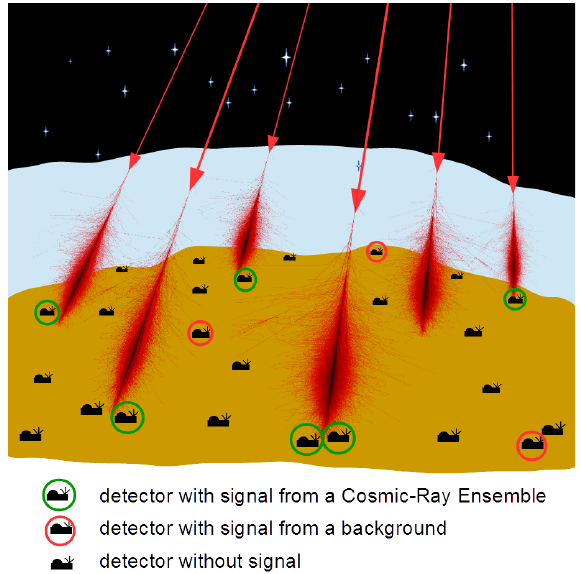
Figure 1. Detection of the Cosmic-Ray Ensemble (CRE) in dis- tributed cosmic-ray